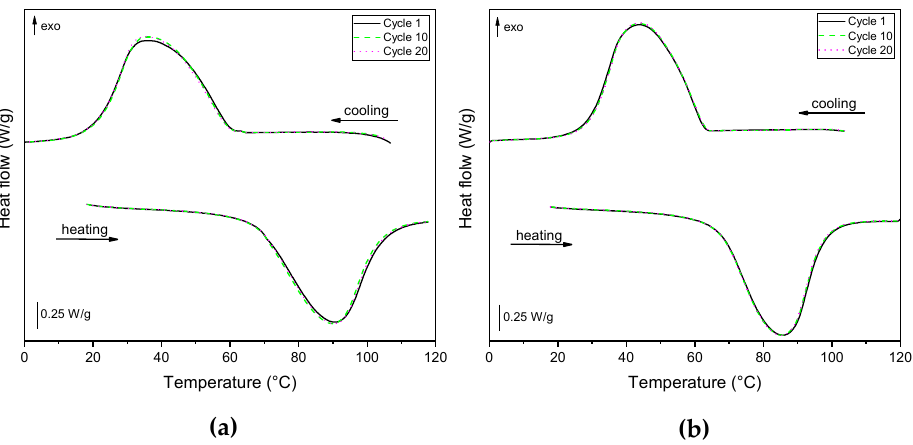
Figure 5. DSC thermograms of the 1st, 10th, and 20th cycles on ( a ) EPDM_H_P60 and ( b ) EPDM_MP_P60.